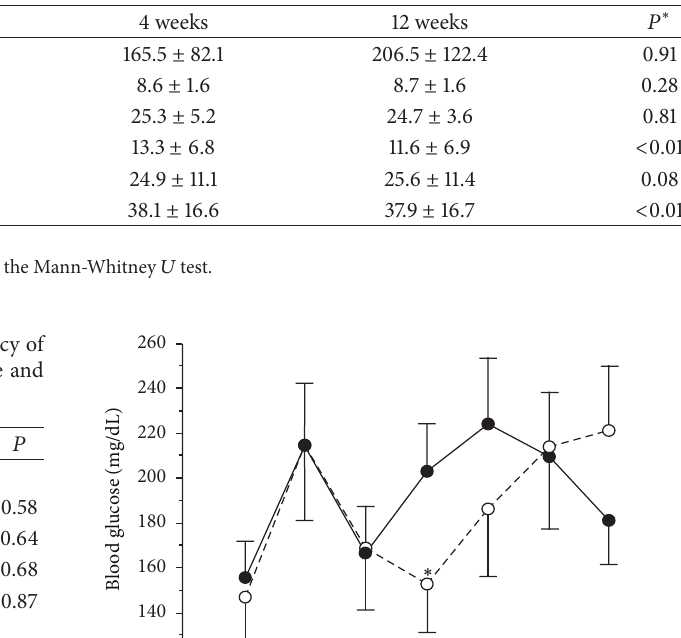
Table 2: Effects of switching to insulin degludec on glycemic control.